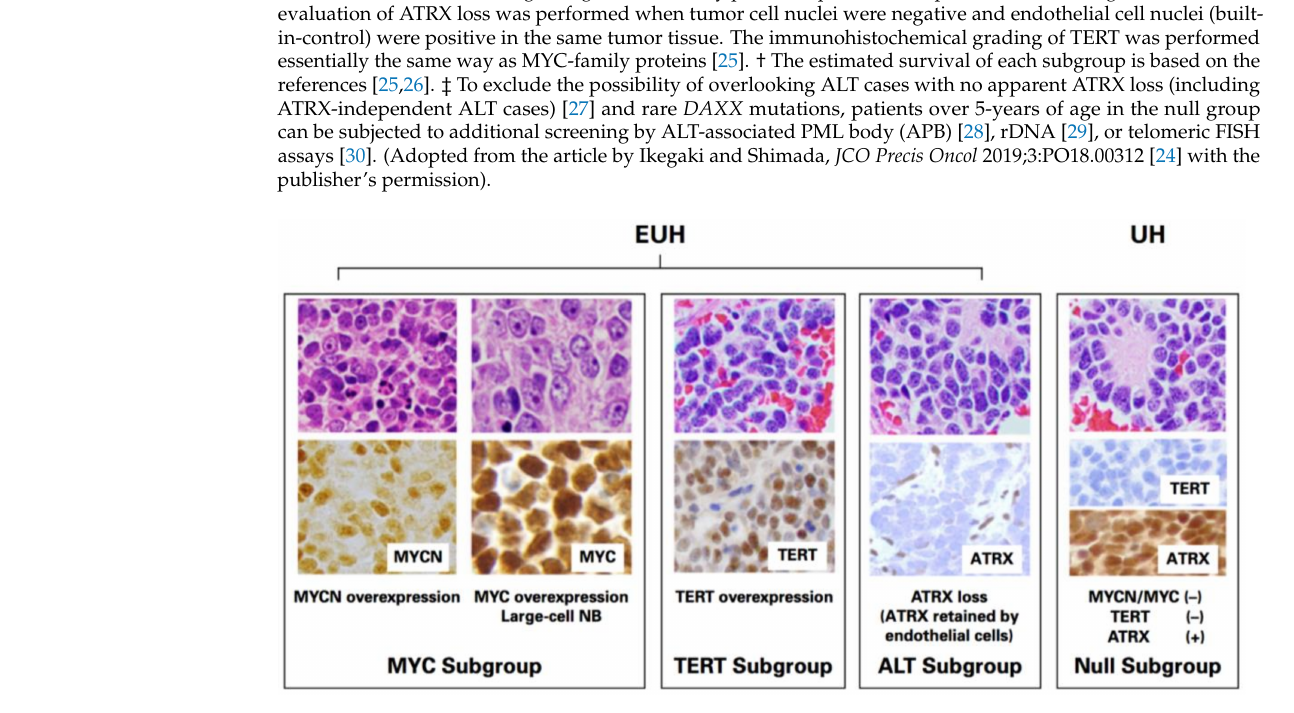
Figure 5. Proposed subgroupings of unfavorable histology neuroblastomas. Four subgroups, i.e., MYC (overexpressing either MYCN or MYC protein), TERT ( TERT gene activation due to rearrange- ments), ALT (due to ATRX or DAXX loss) and null (no MYC, No TERT, no ALT), are distinguished immunohistochemically. EUH, extremely unfavorable histology; UH, unfavorable histology. The im- munohistochemical grading of MYC-family protein expression was performed according to Ref.